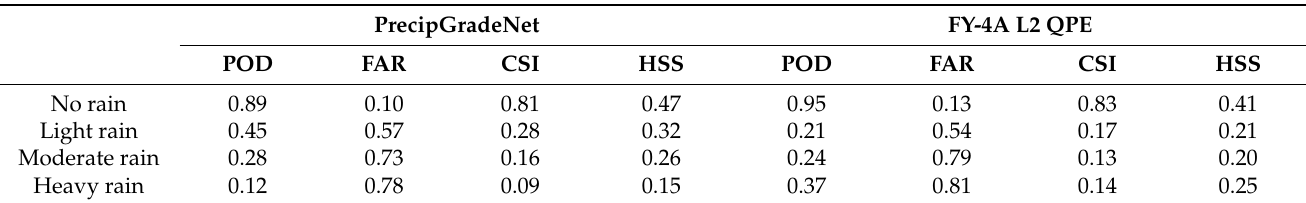
Table 9. Summary of the PrecipGradeNet and FY-4A L2 QPE detection performance for different precipitation intensity intervals during the evaluation period of 4 August 2021 to 7 October 2021, total 3,370,943